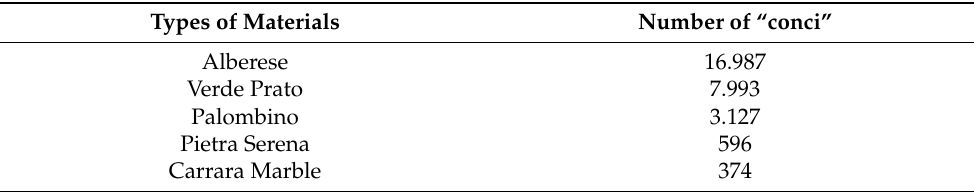
Table 4. Types of materials of the Duomo di Prato and number of “conci”.